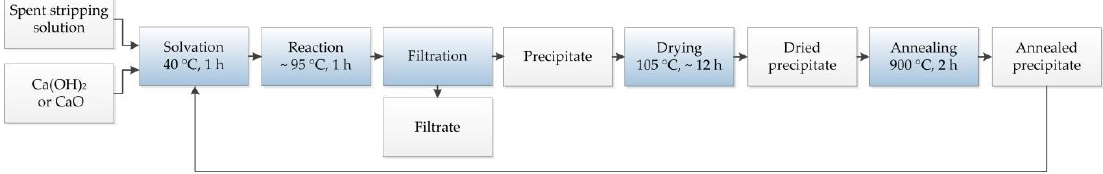
Figure 2. Principal flow chart for the processing of used stripping solutions [3].